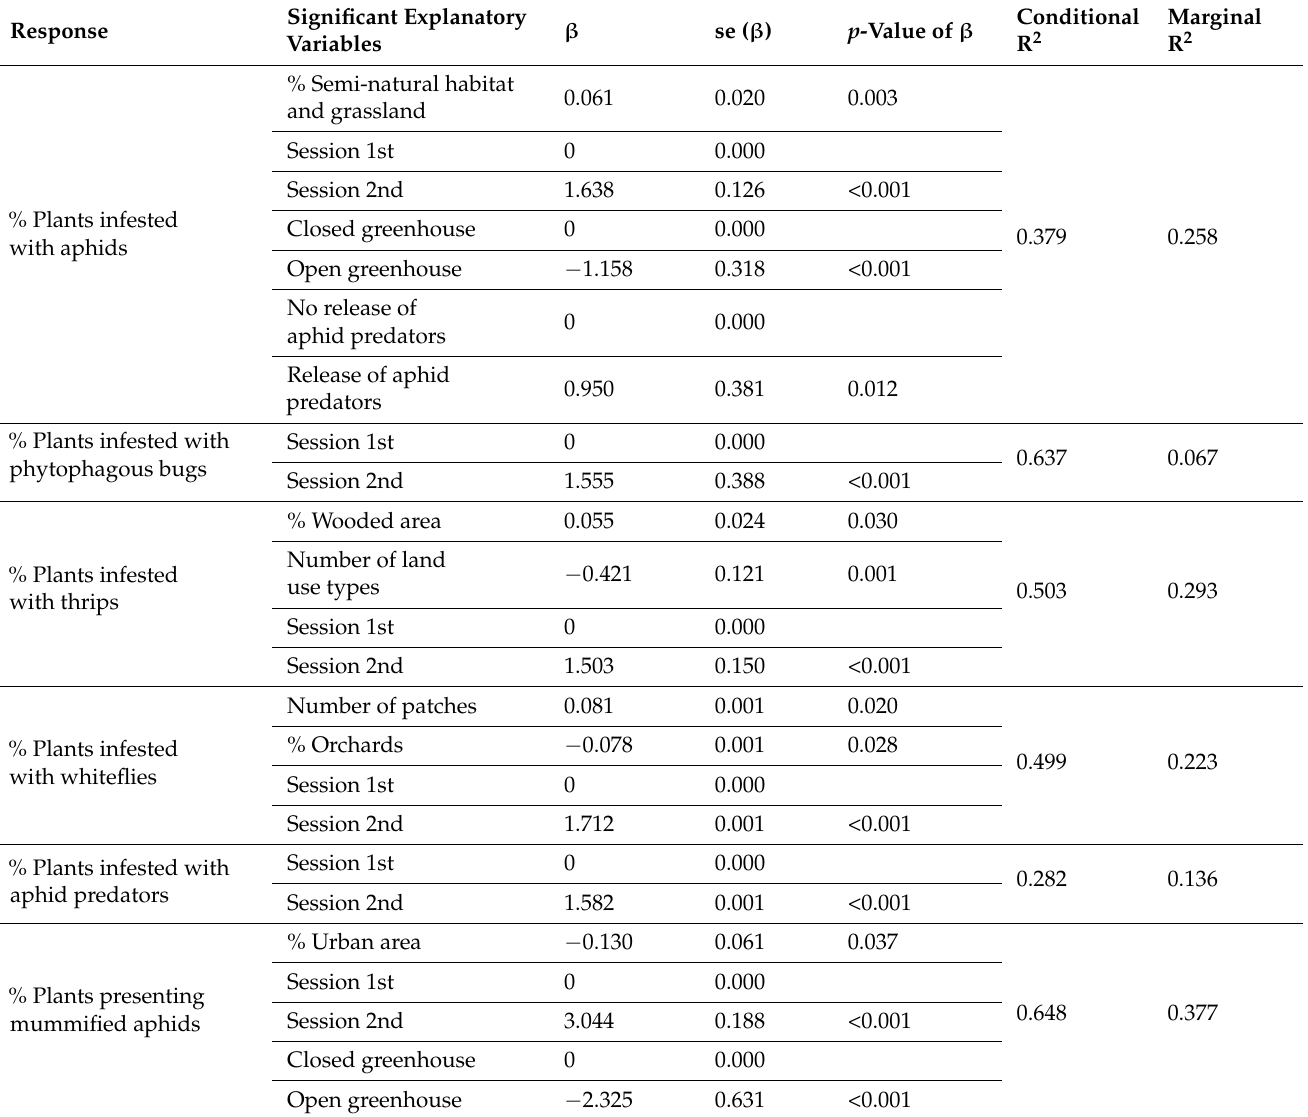
Table 3. Effects of the landscape metrics, sampling session, the degree of openness of greenhouses and pest management practices on the insect crop colonization in greenhouse strawberry crops (Generalized Linear Mixed Models). Significance of the explanatory variables was corrected by the Hochberg–Benjamini FRD. β : coefficient estimates of the significant covariate; se: standard error of estimates. Conditional R 2 refers to the contribution of both fixed and random effects to the response variance explained by the model. Marginal R 2 refers to the contribution of fixed effects to the response variance explained by the